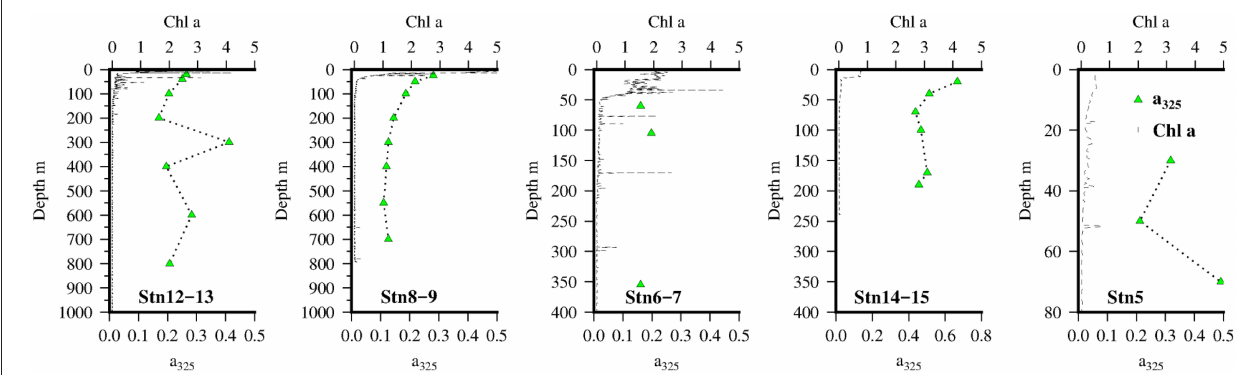
FIGURE 3 | Vertical distribution of chlorophyll a (black line)and a 325 (green triangles) at the 5 Go-Flo stations along the transect in the Mauritanian Upwelling.